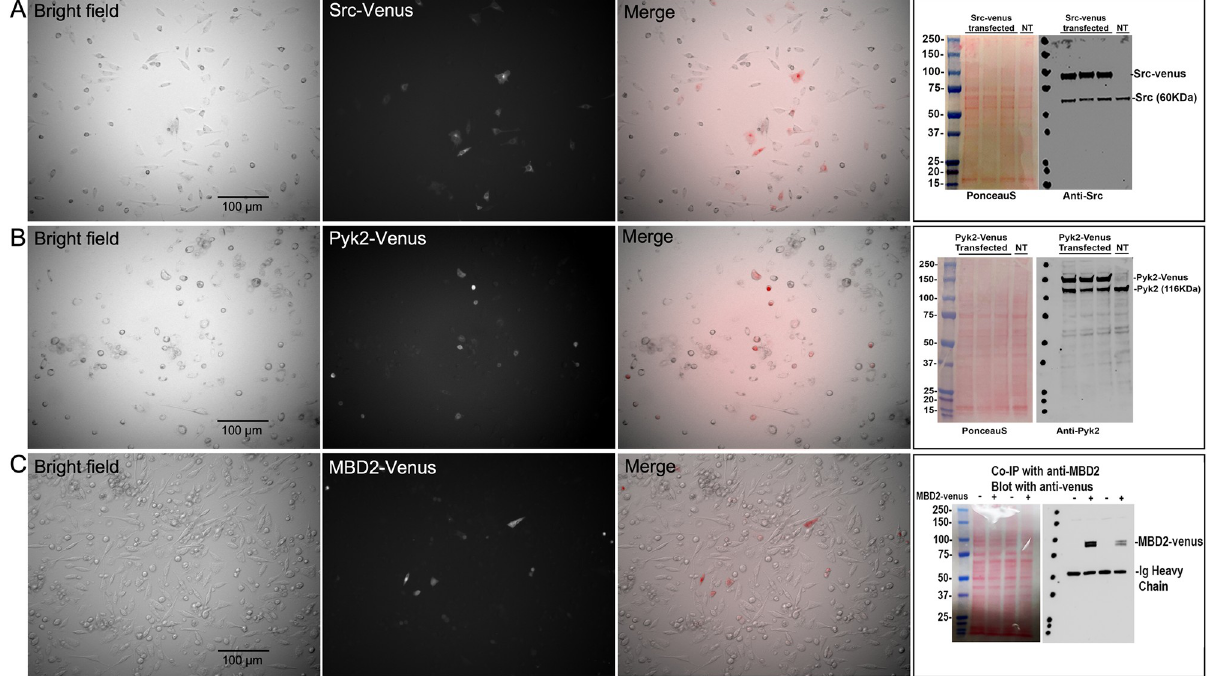
Fig 1. Evaluation of fluorescent protein expression levels in MLO-Y4 cells. Rows A, B and C show cells transfected with either Src-Venus, Pyk2-Venus or MBD2-Venus respectively, and imaged at low (10X objective) magnification to evaluate the range of expression levels across a population of cells. In each row, a representative Brightfield image is shown (to show all cells), the corresponding fluorescent channel (to show transfected cells expressing the fusion protein) and a merged image of Brightfield and fluorescence. For Src-Venus and Pyk2-Venus cells were also harvested (in triplicate) and analyzed by immunoblot to estimate the relative levels of exogenous (FP-tagged) and endogenous protein using antibodies against Src (Row A) or Pyk2 (Row B). Antibodies against Src and Pyk2 recognized both the endogenous protein as indicated as well as the higher molecular weight Venus-tagged fusion protein (migrating approximately 27 KDa higher than the endogenous protein, consistent with the expected size of Venus; Rows A and B). Densitometry of bands in all three replicates for both Src and Pyk2 showed that the Venus-tagged fusion protein were expressed at levels between 2–4 times higher than the endogenous protein. In contrast, MBD2-Venus fusion protein could not be detected at the predicted molecular weight (~90–95 kDa) by any of 4 different antibodies against MBD2 that were able to recognize endogenous MBD2 (not shown). We concluded that MBD2-Venus was expressed at much lower levels than endogenous MBD2. As an alternative approach to confirm expression of MBD2-Venus, we performed a co-immunoprecipitation (co-IP) experiment using antibody against MBD2 for the IP, following by an anti-GFP antibody for the western blot of co-IP complexes (Row C). Antibody against GFP (which recognized Venus) detected a band at a molecular weight of approximately 90–95 KDa corresponding to the expected size of the MBD2-Venus